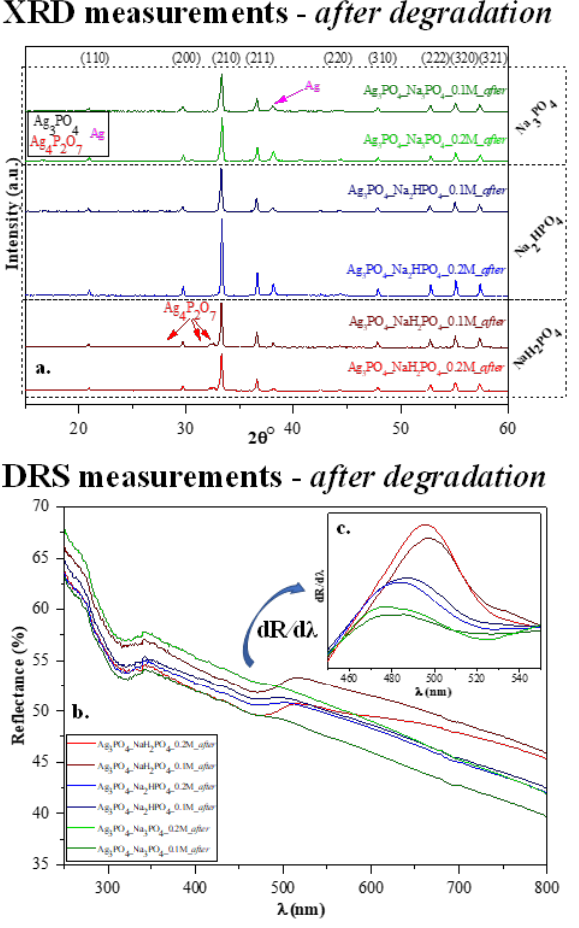
Figure 7. Stability measurements carried out after photocatalytic degradation: ( a ) XRD patterns and ( b ) DR spectra and ( c ) insert figure: their first derivative order. The term “ after ” was used in the sample names to indicate that the results were obtained after MO degradation.